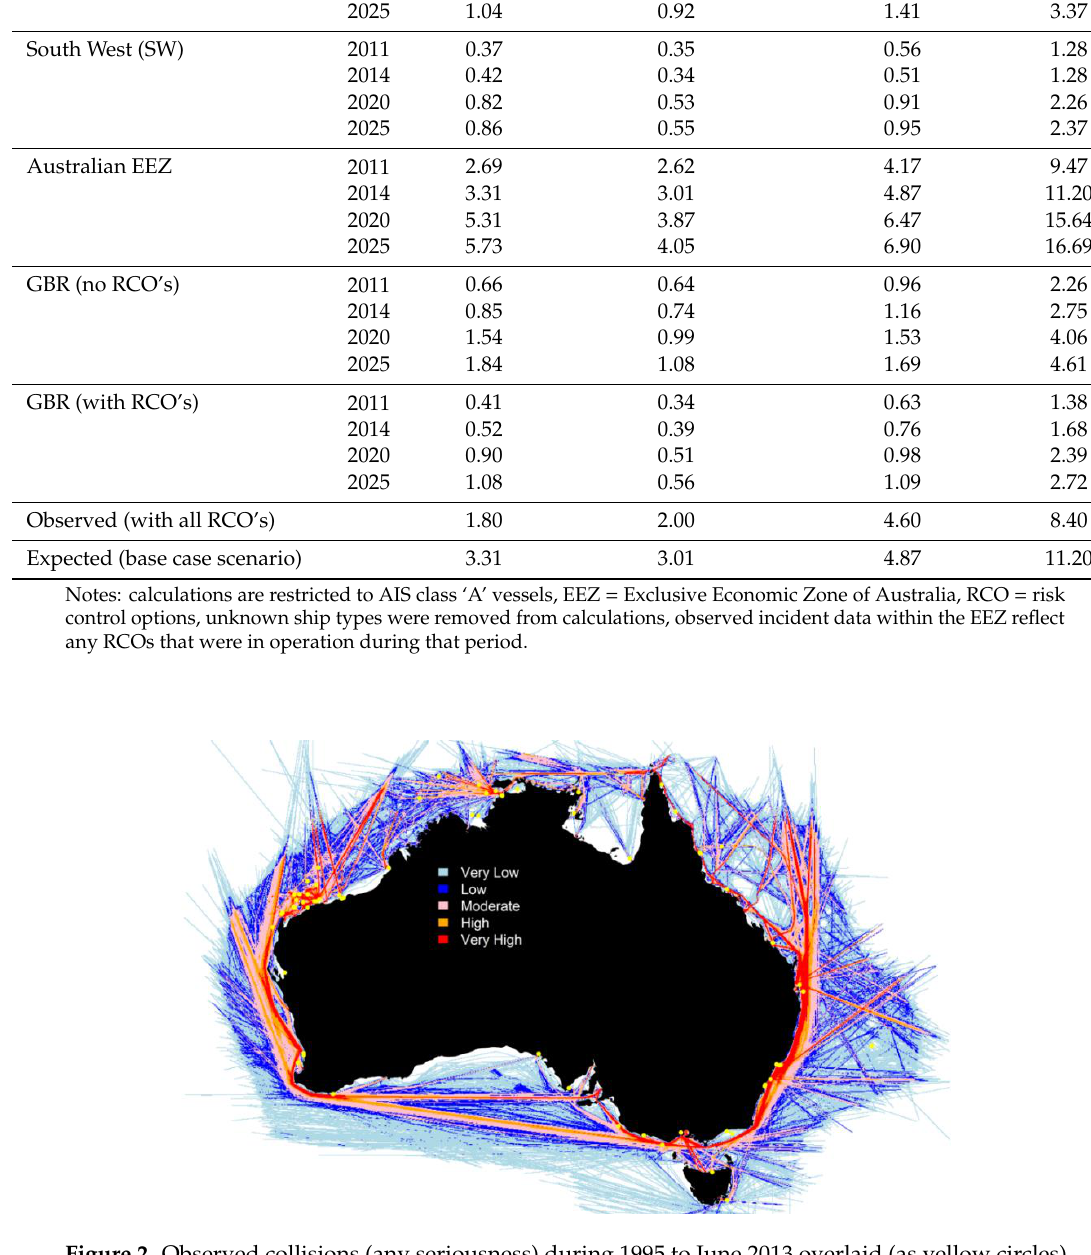
Figure 3. Change in risk exposure for powered groundings in 2020 ( left ) and 2025 ( right ) compared. 4. Discussion and Conclusions The proposed strategic planning tool based on a multi-layered risk estimation framework provides a relatively straight forward approach to maritime risk assessment at the macro level with the possibility to downscale to the micro level by integrating a spatial correction factor. Its main purpose is to provide maritime administrations and coastal states with the means to run prediction scenarios for medium to long term planning aspects in order to allocate assets more effectively. The multi-layered approach can also be adopted for the daily or short-term operational aspect where layers can be combined to create an automated monitoring and alert system to enhance traffic monitoring. This will help coastal states to know as early as possible if a potentially dangerous situation is occurring and intervene to prevent incidents from happening in the first place. The major difference compared to other approaches in risk assessment for strategic planning is that total risk exposure is divided into layers at the grid level, which can be treated individually or in a combined format. As such, the proposed approach allows the combination of the risk layers with a flexible spatial resolution. One of its main advantages is that it starts at the ship level by capturing safety qualities of ships that trade in a specific area and which can, therefore, reflect how risk will be heterogenous across ships as well as areas. Several extensions of this application include: (1) to improve estimation of risk at different spatial scales, (2) to assess risk over time, and to (3) predict risk in the future given risk control scenarios and, lastly, (4) to use a combination of the risk layers to create an automated surveillance and alert system to enhance incident prevention. Another possible extension is to add a metric that quantifies potential incident consequences, e.g., the monetary value at risk, which can be estimated